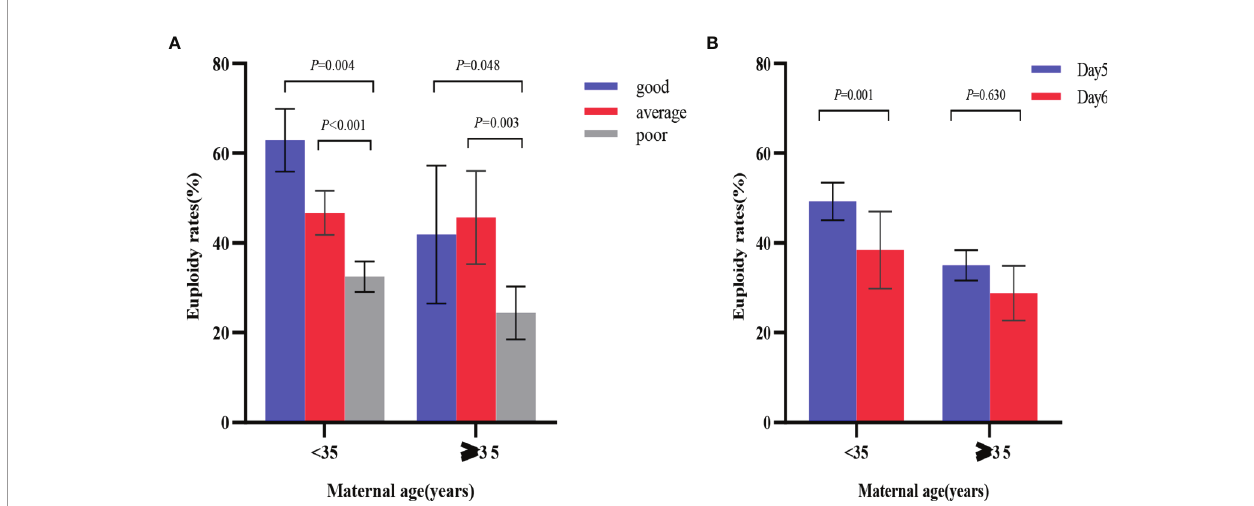
FIGURE 2 | Comparison of euploidy rates by blastocyst morphology and developmental rates in the two age groups. (A) odds ratio was adjusted for blastocyst developmental rate, maternal age, maternal BMI, duration of infertility, type of infertility, infertility diagnosis, number of prior pregnancies, indication for PGT-A and basal FSH; (B) odds ratio was adjusted for blastocyst morphology, maternal age, maternal BMI, duration of infertility, type of infertility, infertility diagnosis, number of prior pregnancies, indication for PGT-A and basal FSH. P values are adjusted p